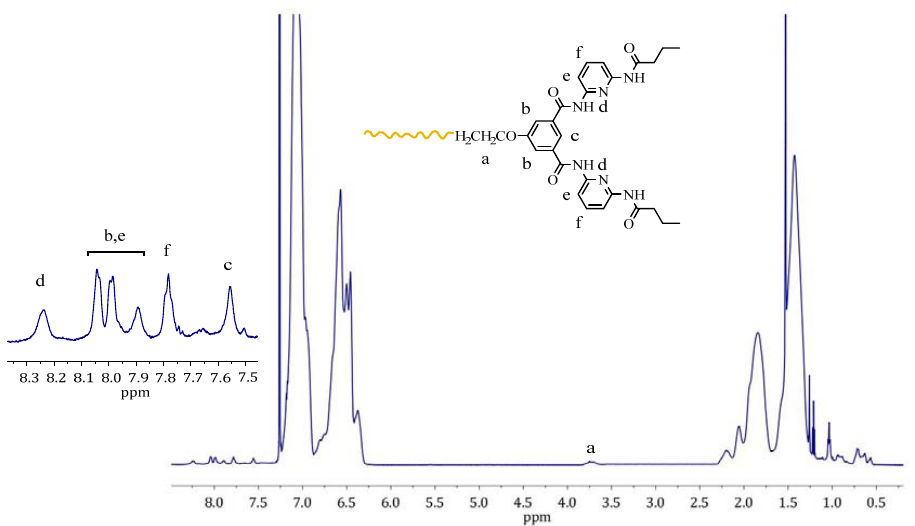
1 H-NMR spectrum of sample Figure 5. 1 H ‐ NMR spectrum of sample PS ‐ Ham. Figure 5.